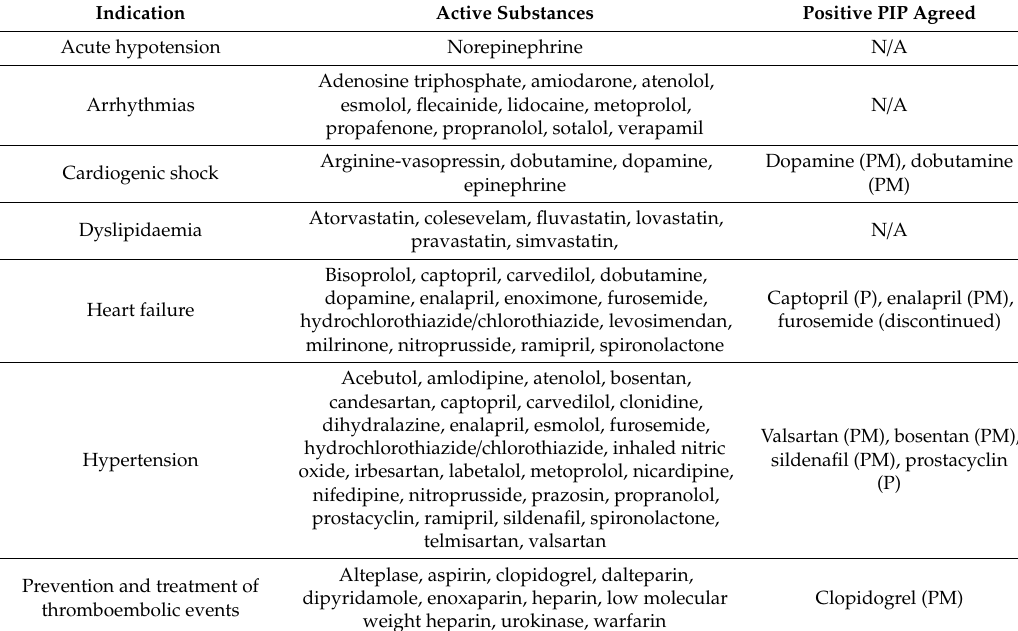
See methods for details on data